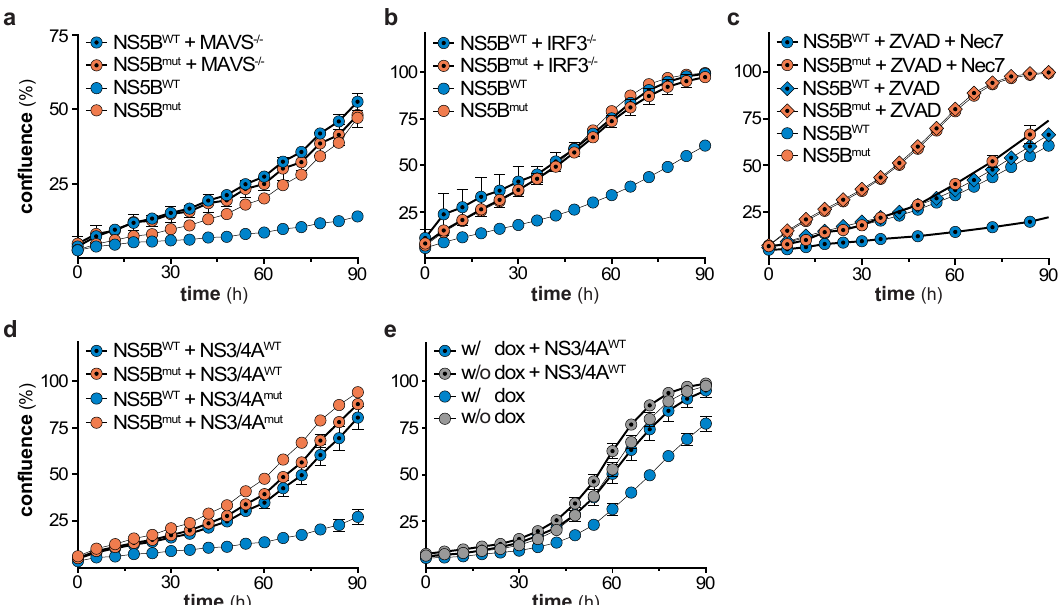
Figure 6. Mitochondrial antiviral signaling protein (MAVS)- and interferon regulatory factor 3 (IRF3)-dependent negative selection of NS5B expressing cells and rescue by HCV NS3 / 4A. ( a ) Cell growth of wild-type and MAVS knock-out A549 cells, 5 days after transduction of either NS5B WT or NS5B mut (mean ± s.d. of n = 5 technical replicates). One representative of n = 3 independent experiments is shown. ( b ) Cell growth of wild-type and IRF3 knock-out A549 cells, 5 days after transduction of either NS5B WT or NS5B mut (mean ± s.d. of n = 5 technical replicates). One representative of n = 3 independent experiments is shown. ( c ) Cell growth of DMSO, Z-VAD-FMK (ZVAD, 40 µ M), or Necrostatin-7 (Nec7, 10 µ M) treated A549 cells, 5 days after transduction of either NS5B WT or NS5B mut (mean ± s.d.